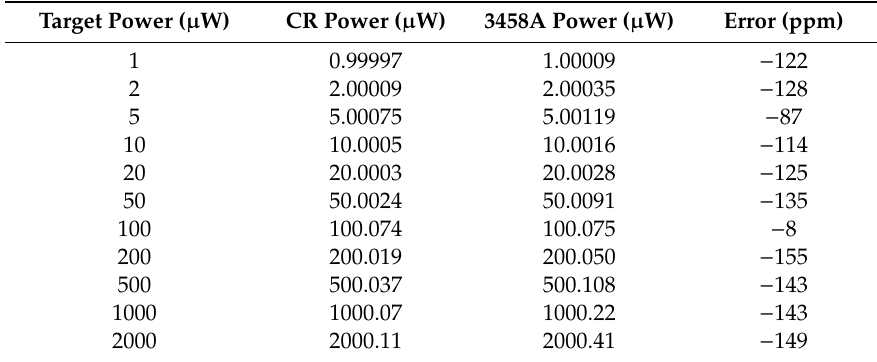
Table 3. L-1 cryogenic radiometer standard Watt.